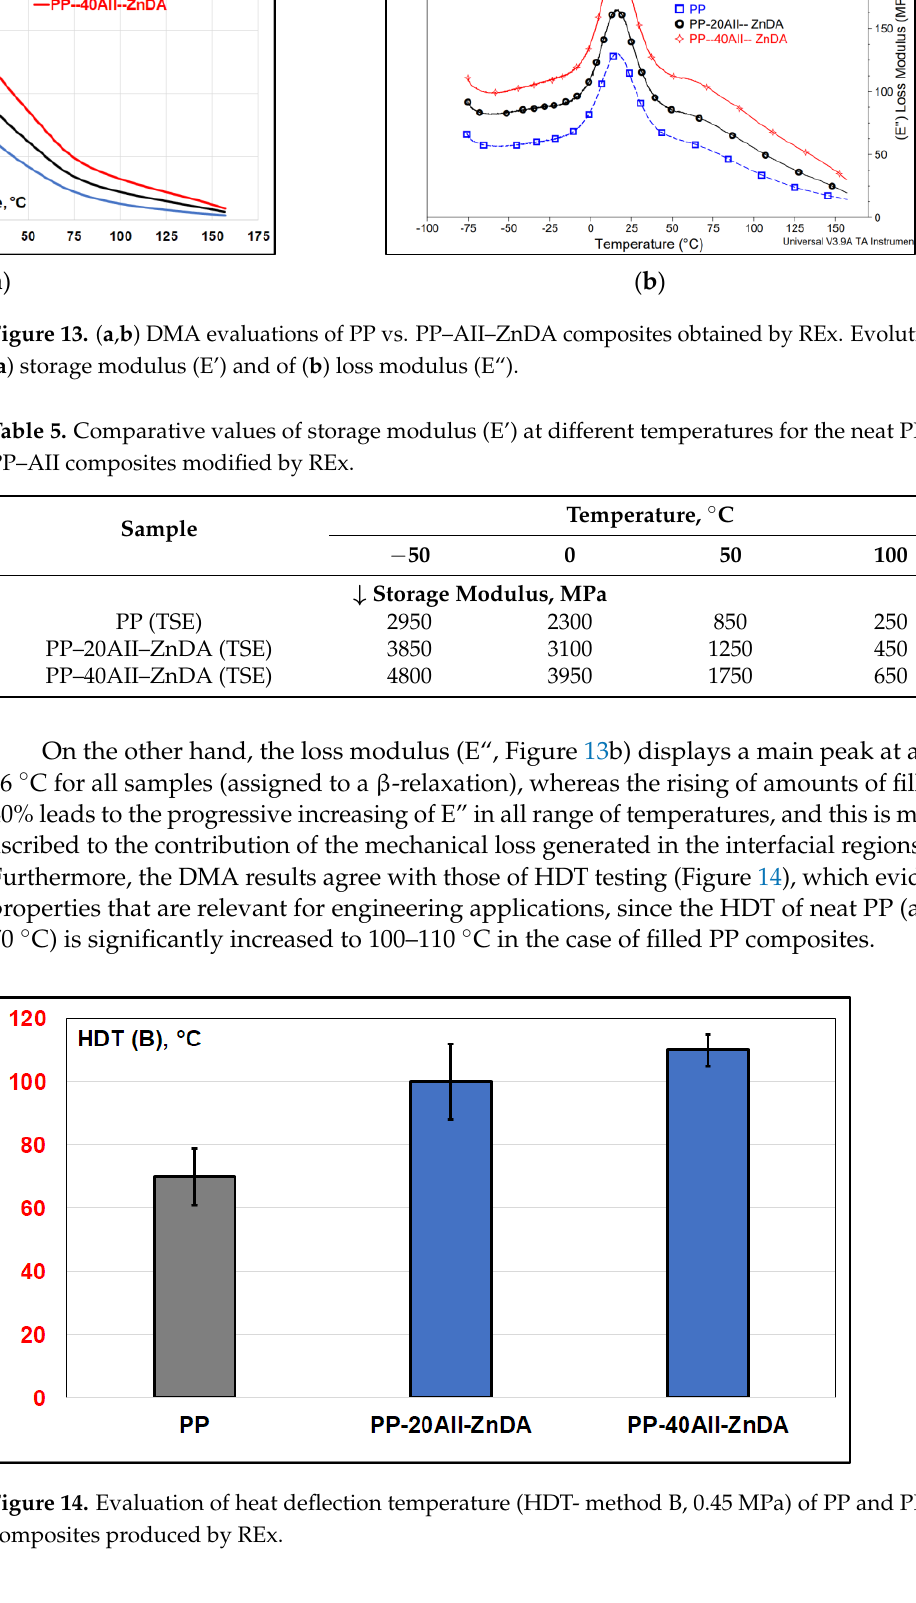
Figure 14. Evaluation of heat deflection temperature (HDT- method B, 0.45 MPa) of PP and PP – AII composites produced by REx.